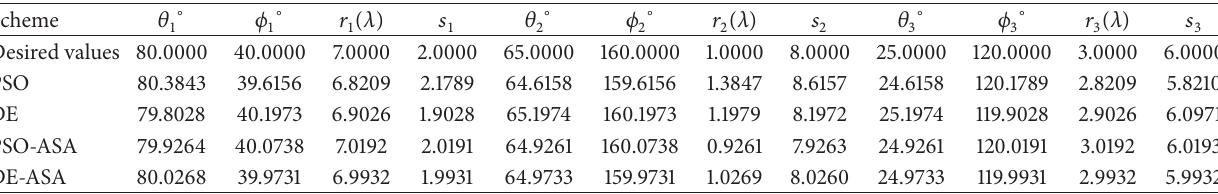
Table 3: Estimation accuracy for 3 targets.